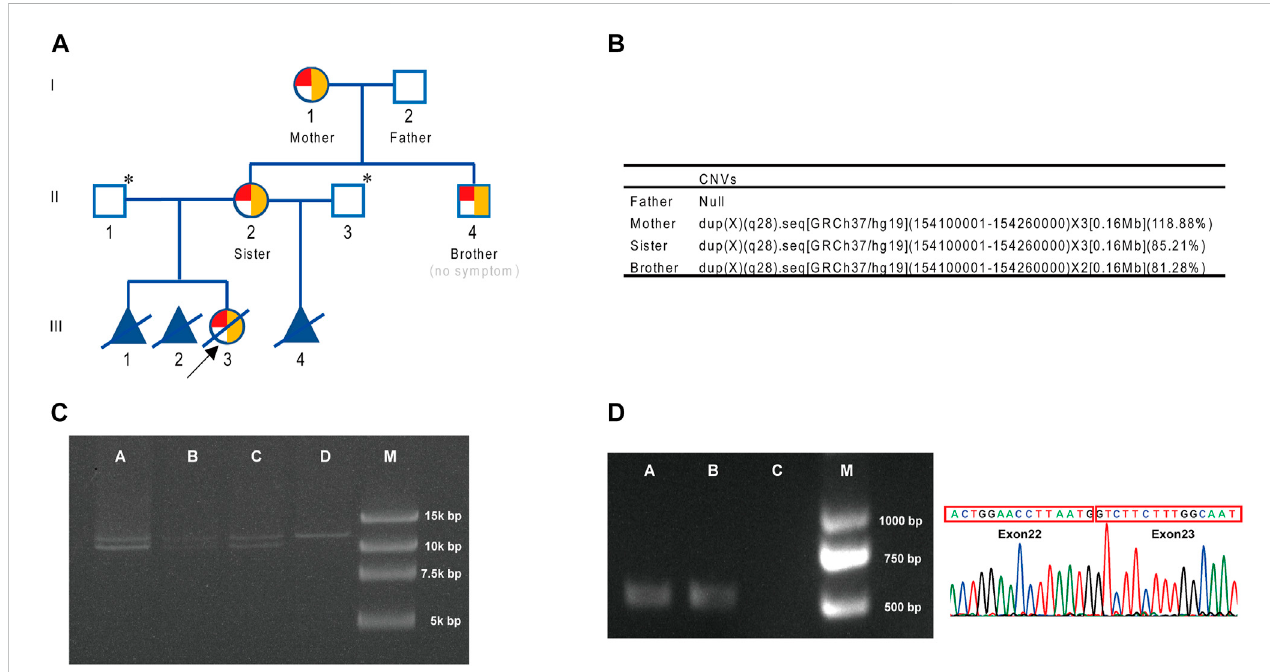
Pedigree and genetic analysis. (A) Genogram for the family (with CNV and inversion results). Red for inversion, 1/4 red circle for heterozygosis, 1/2 red circle for homozygosis, and yellow for duplication. * indicates that F8 gene analysis was not performed. (B) CNV results for the family. (C) Inv22 assay for the